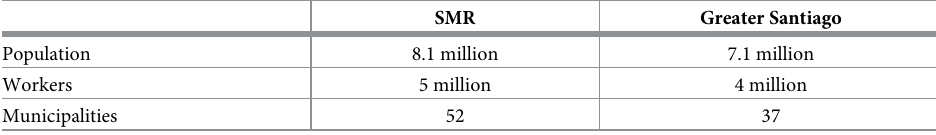
Table 1. Santiago Metropolitan Region descriptive